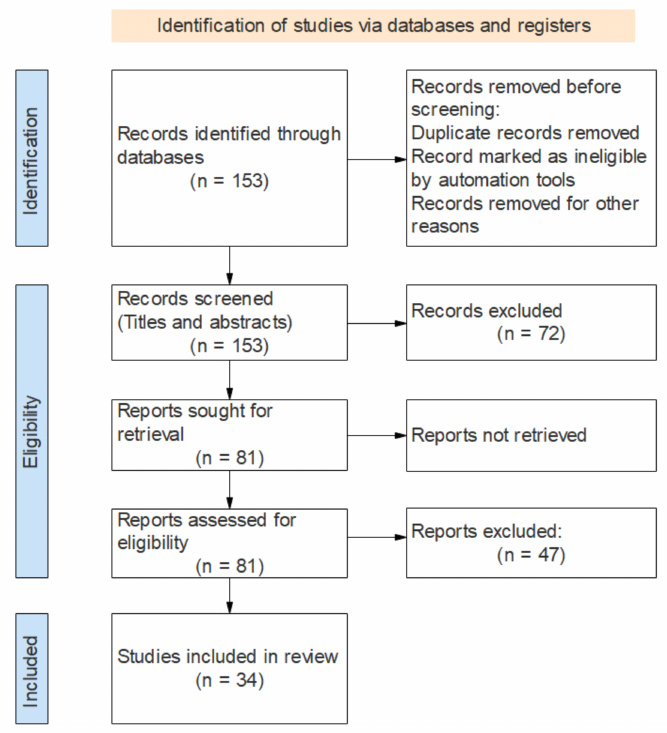
Figure 2. Flow diagram of the systematic review (PRISMA).